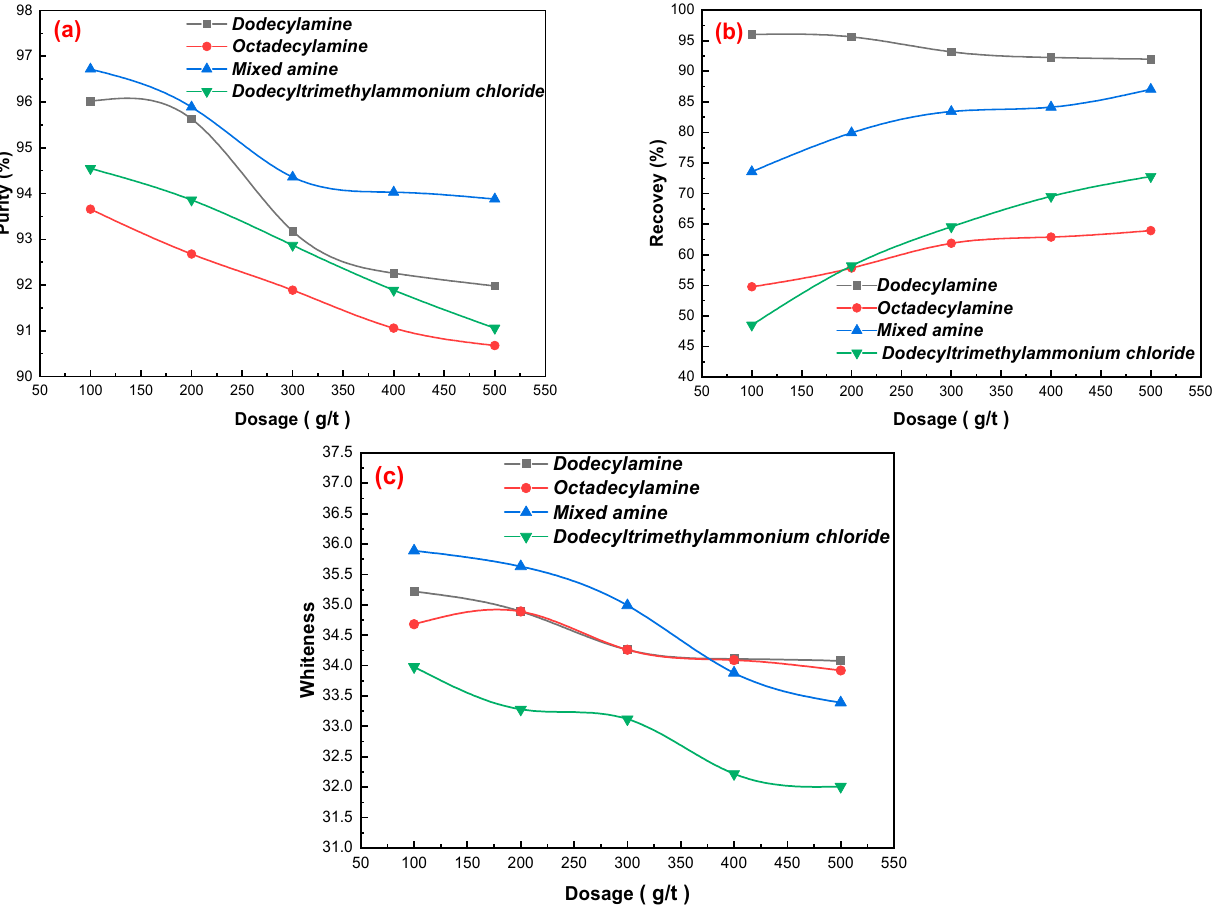
Figure 2. Effects of dosages of dodecylamine, octadecylamine, mixed amine, and dodecyltrimethy- lammonium chloride on gypsum purification: ( a ) gypsum purity, ( b ) gypsum recovery, and ( c ) gypsum whiteness. Table 2. Grain-sized analysis of phosphogypsum (mass fraction, %).